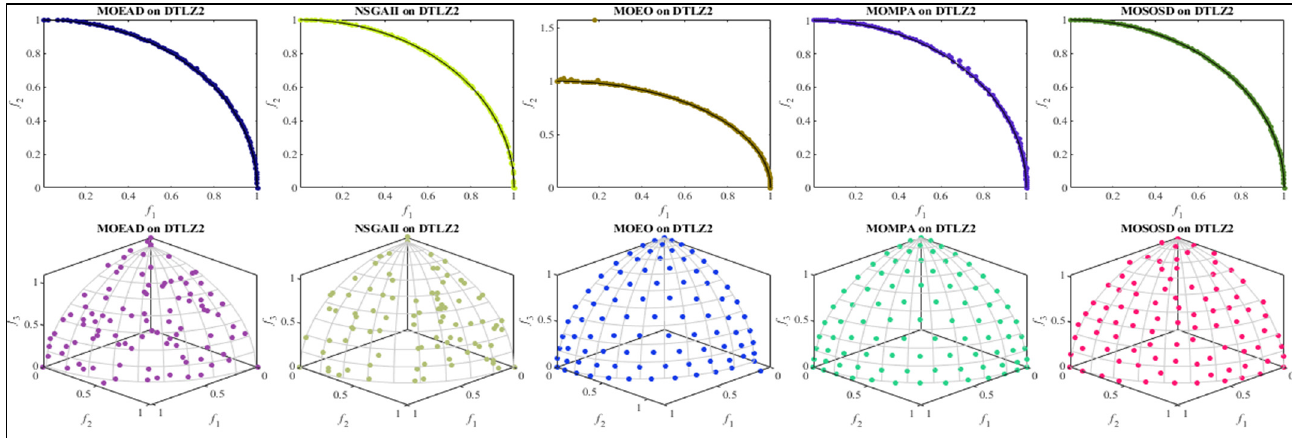
Figure 3. The Pareto front for DTLZ2 using various algorithms at M = 2, 3.